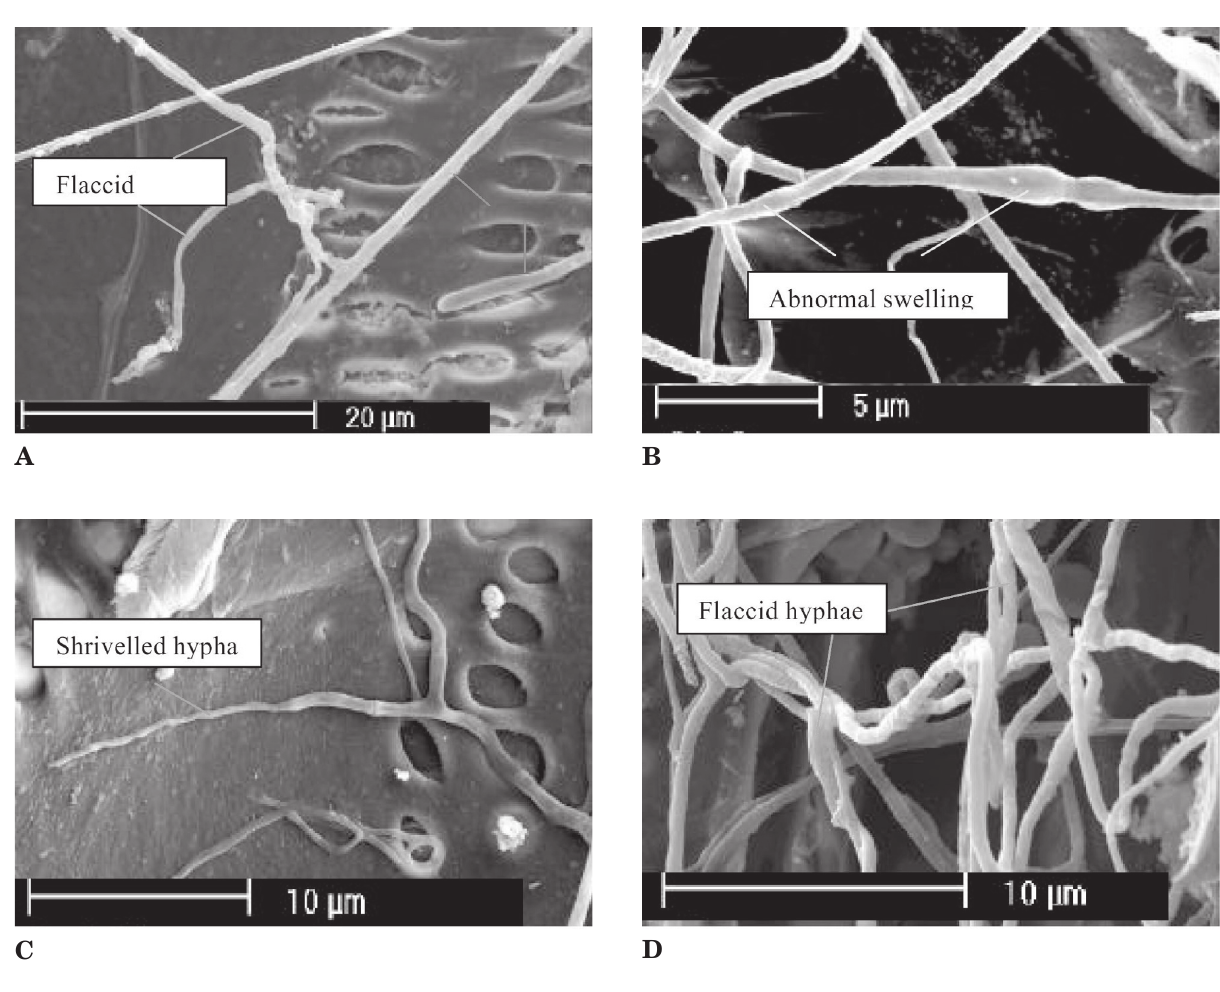
Figure 5. SEM of cuttings inoculated with E. lata and 2 days later with T. harzianum . A. Flaccid hyphae in cutting co-inoculated with mycelial plugs. B. Abnormal swelling of hyphae in cutting co-inoculated with mycelial plugs. C. Shrivelled hypha in cutting co-inoculated with mycelial plugs. D. Loss of turgidity and parallel growth of hyphae in vessel of cutting co-inoculated with